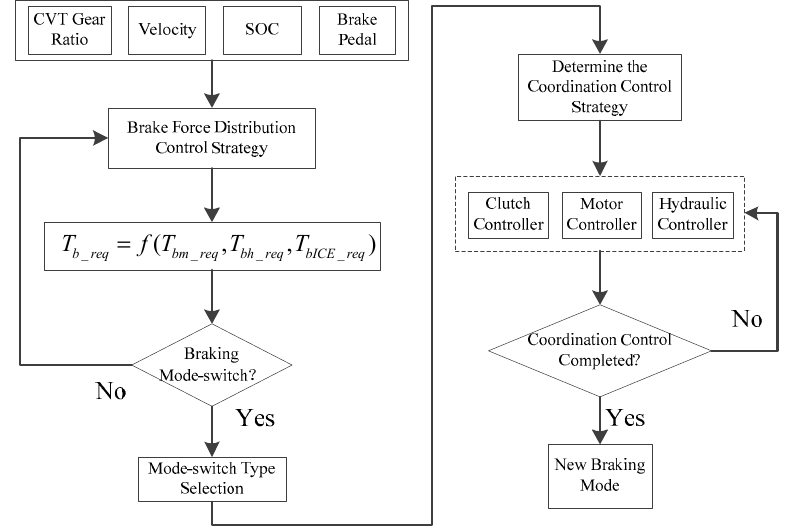
Figure 7. Flow chart of overall coordination control.